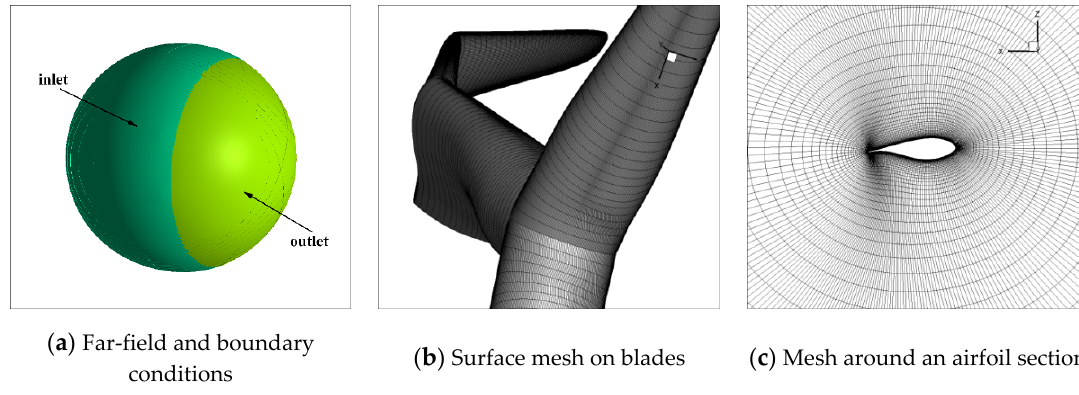
Figure 4. Mesh and far-field boundary. Table 1. Grid parameters and performances of grid independency study.